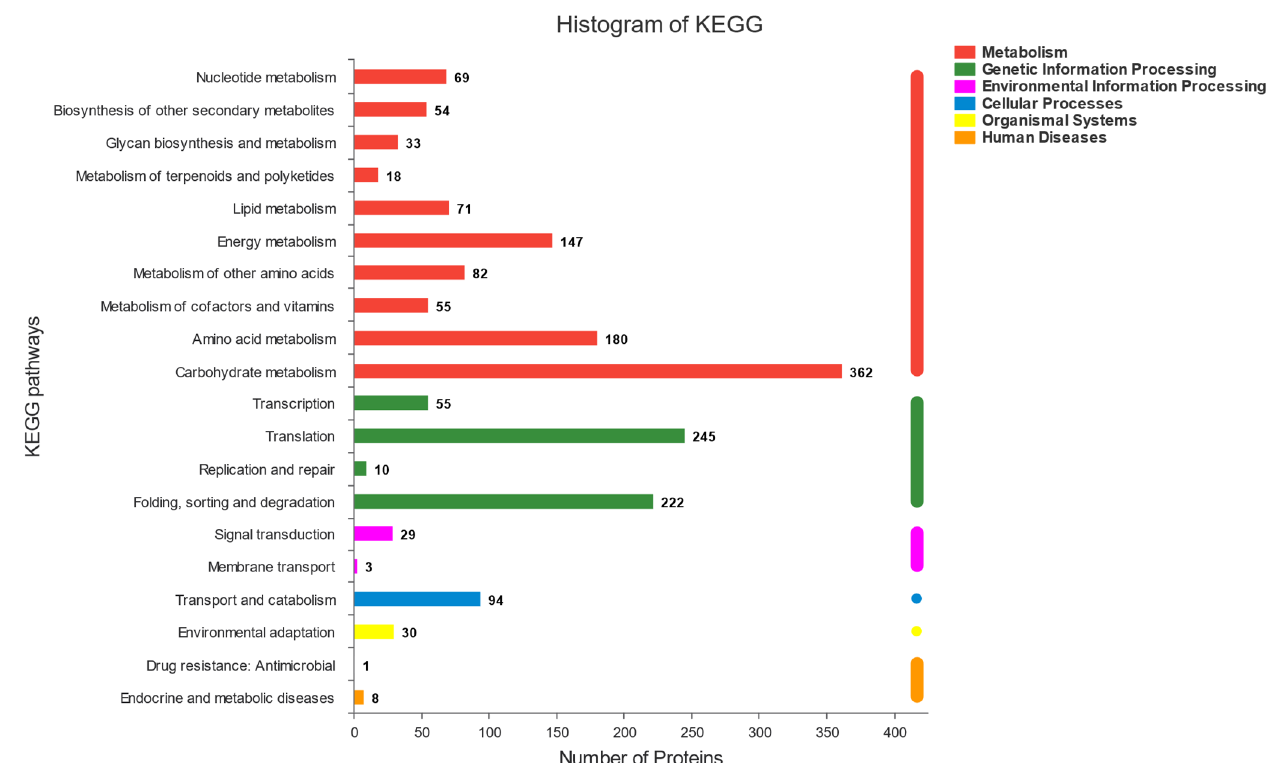
Figure 3. Whole protein function annotation.